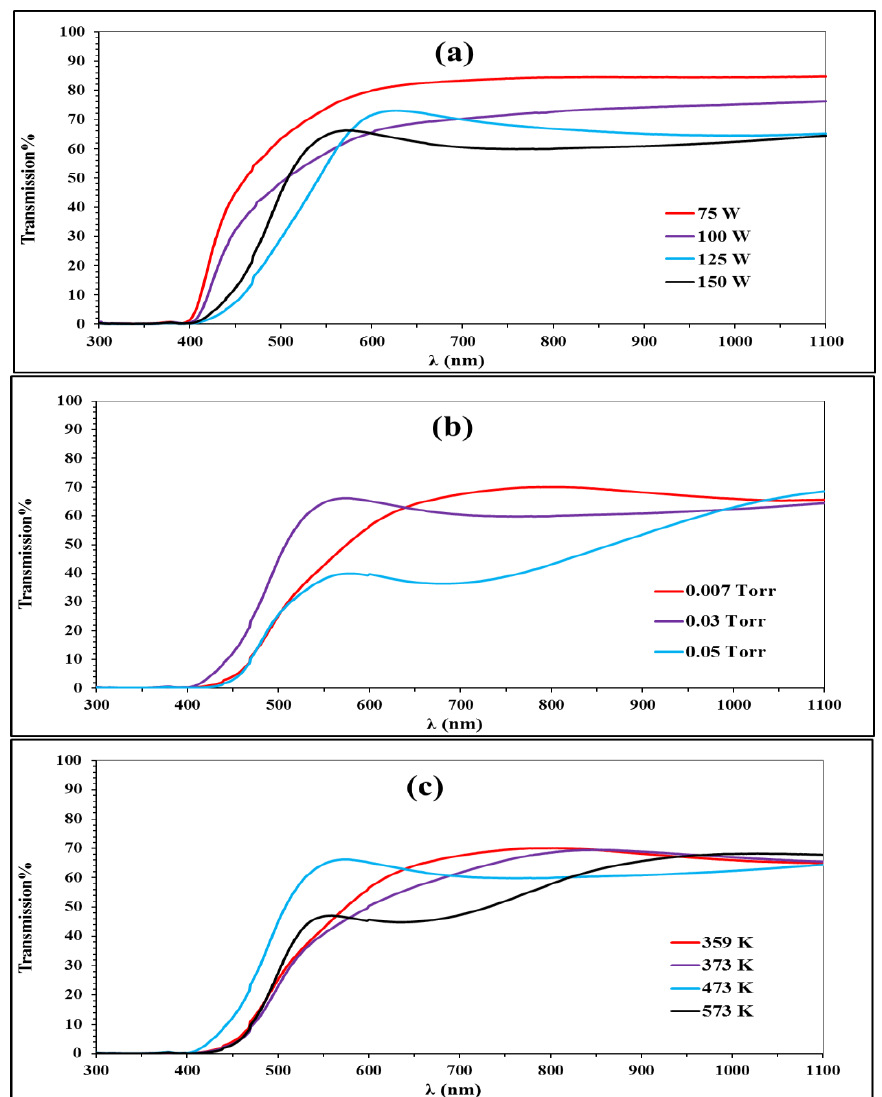
Fig.1: The transmittance of the (V working pressure and temperature substrate versus